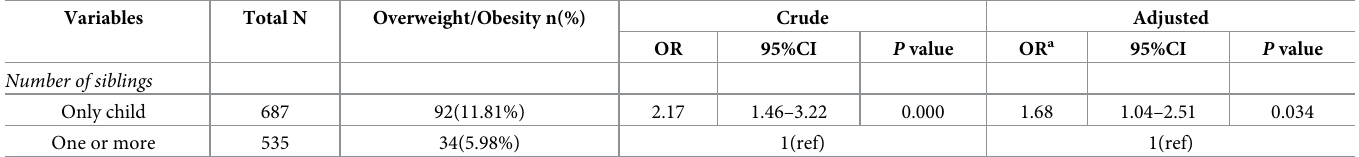
Table 2. Logistic regression models examining the association between the number of siblings and overweight/obesity.